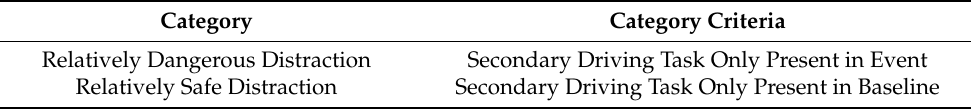
Table 5. Secondary driving task category criteria with the presence of value